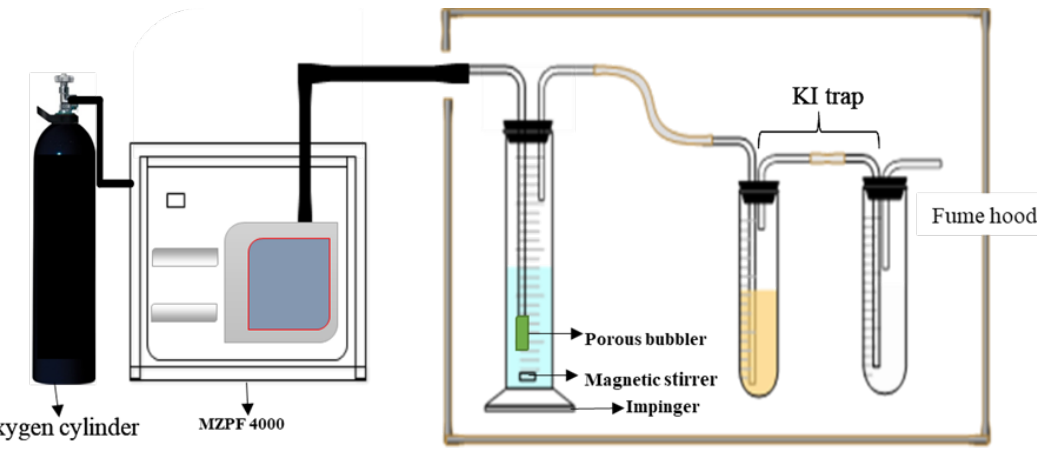
Figure 9. The typical reaction setup for the cyclohexane ozonation.